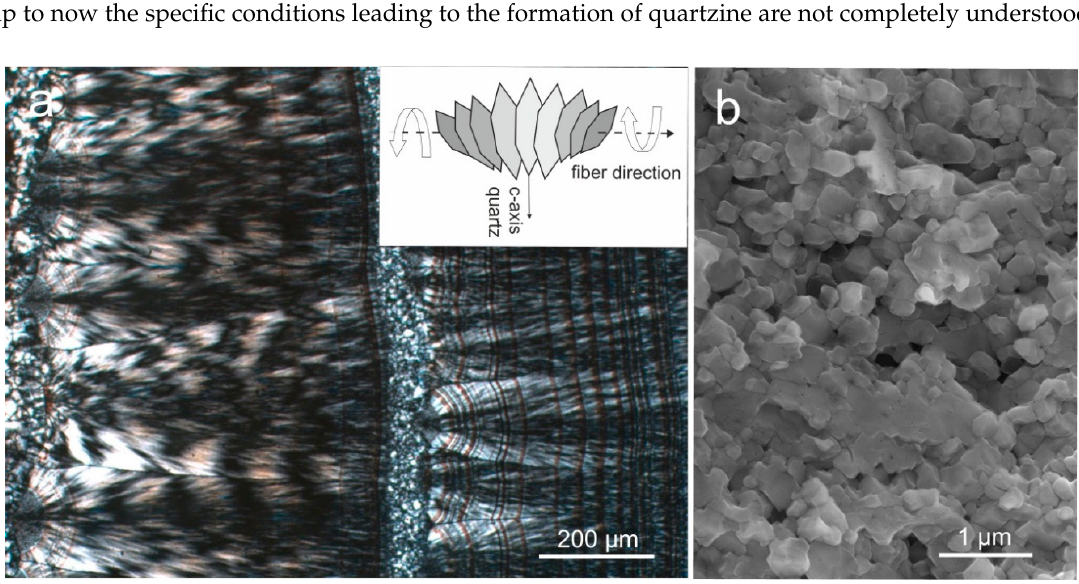
Figure 4. Agate from Xuanhua (Hebei province, China) in transmitted light (crossed polars) ( a ) and with λ compensator ( b ) showing alternating bands of fibrous chalcedony (blue) and quartzine (yellow).